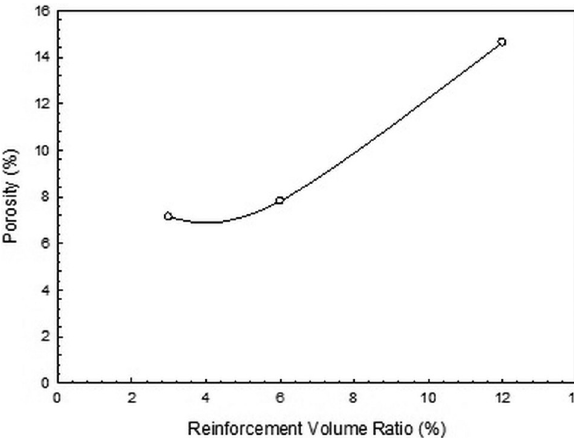
Fig. 5: Porosity values related to reinforcement volume ratio of the composites manufactured in 4 minutes at 500 rev/min stirring speed at 800